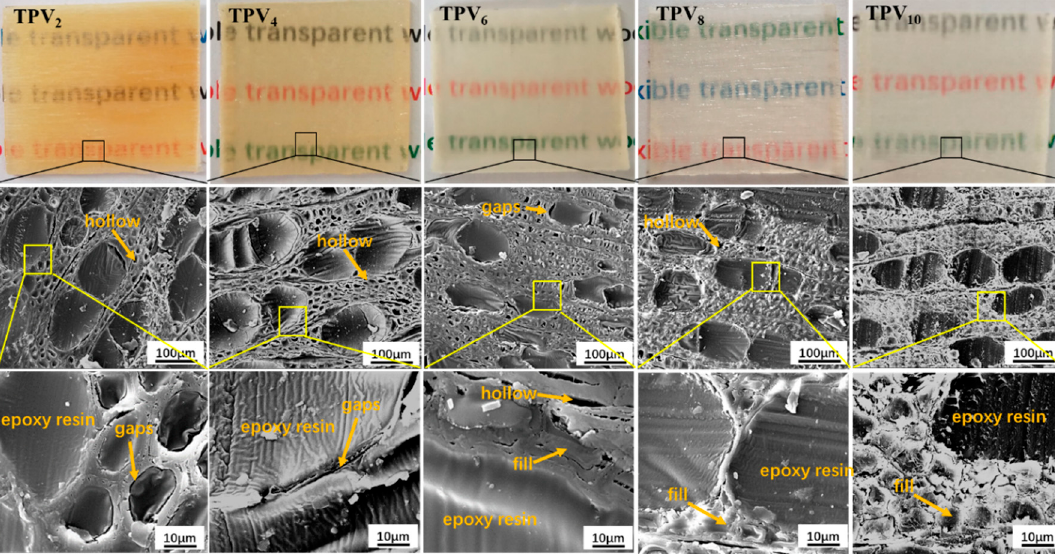
Figure 5. The physical object and the microstructure of TPV 2 , TPV 4 , TPV 6 , TPV 8 and TPV 10 under a magnification of 300 and 2500, respectively.